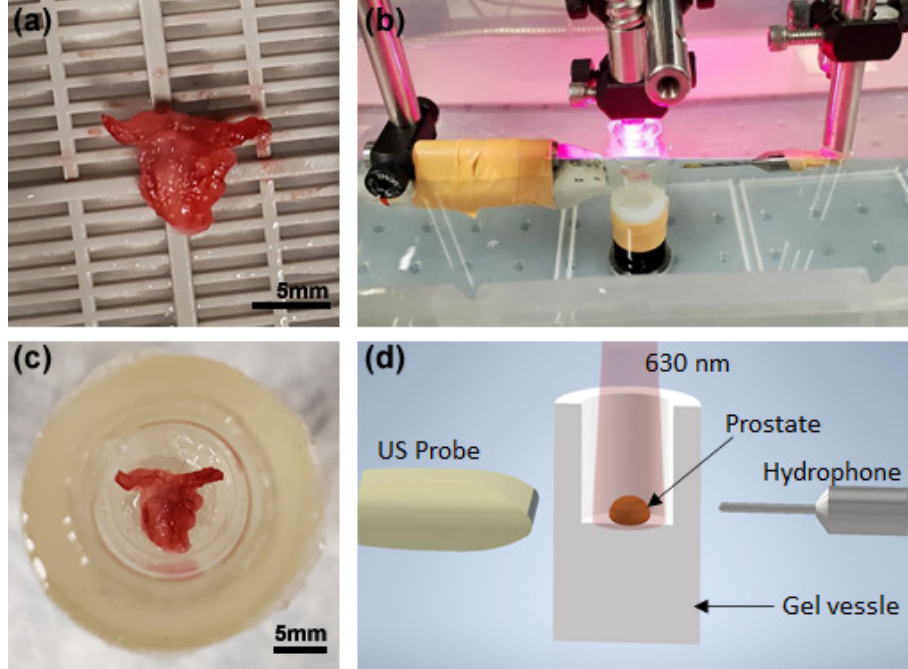
Figure 3. Experimental setup for PA measurement and PA-US dual imaging of TRAMP mouse prostate ex vivo. ( a ) A harvested prostate from a TRAMP mouse at the age of 18 weeks. ( b ) Photograph of experimental setup. ( c ) Prostate embedded in a porcine vessel for US coupling. ( d ) Experimental setup schematic drawing, showing that the PA signals in the prostate induced by the 630 nm laser are measured by a needle hydrophone as well as by a linear US probe for PA-US imaging.